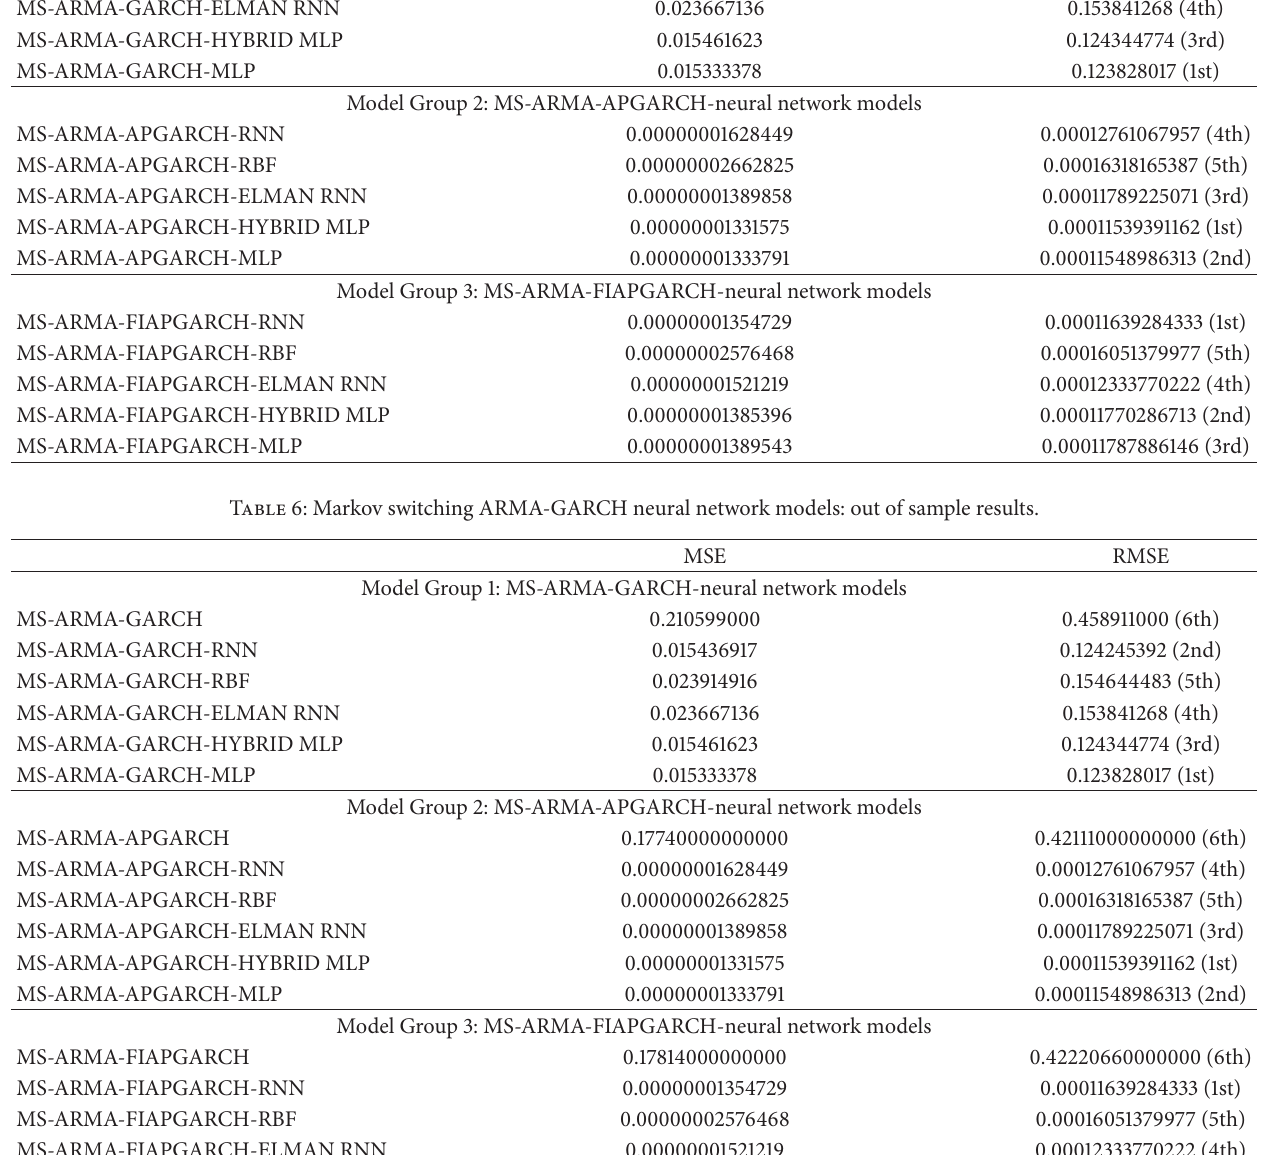
Table 5: Markov switching ARMA-GARCH neural network models: test sample results. MSE RMSE Model Group 1: MS-ARMA-GARCH-neural network models